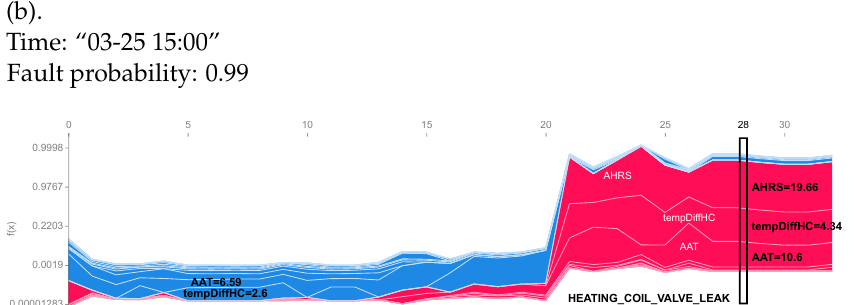
Figure A6. Heating coil valve leakage. SHAP plot for sliding window explanation, visualized from “03-25 08:00” to “03-25 16:00”. Does the above plot explain fan pressure sensor malfunction? (Strongly Agree / Somewhat Agree / Neutral / Somewhat Disagree / Strongly Disagree)